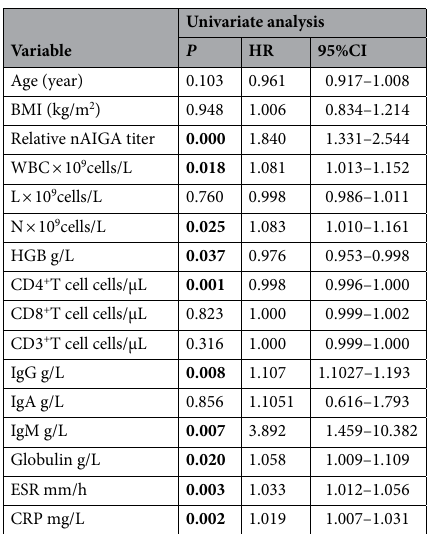
Table 3. Results of univariate analysis for risk factors of TM and NTM co-infection (n = 66). Bold values indicate significant difference between groups or in univariate logistic regression analysis. Relative nAIGA titer indicates the ratio of the actual value to the cut-off value of nAIGA. BMI body mass index, nAIGAs neutralizing anti-IFN-γ auto-antibodies, ND no data, WBC white blood cell, N neutrophil counts, L lymphocyte counts, HGB haemoglobin, ESR erythrocyte sedimentation rate, CRP C-reactive protein, Ig